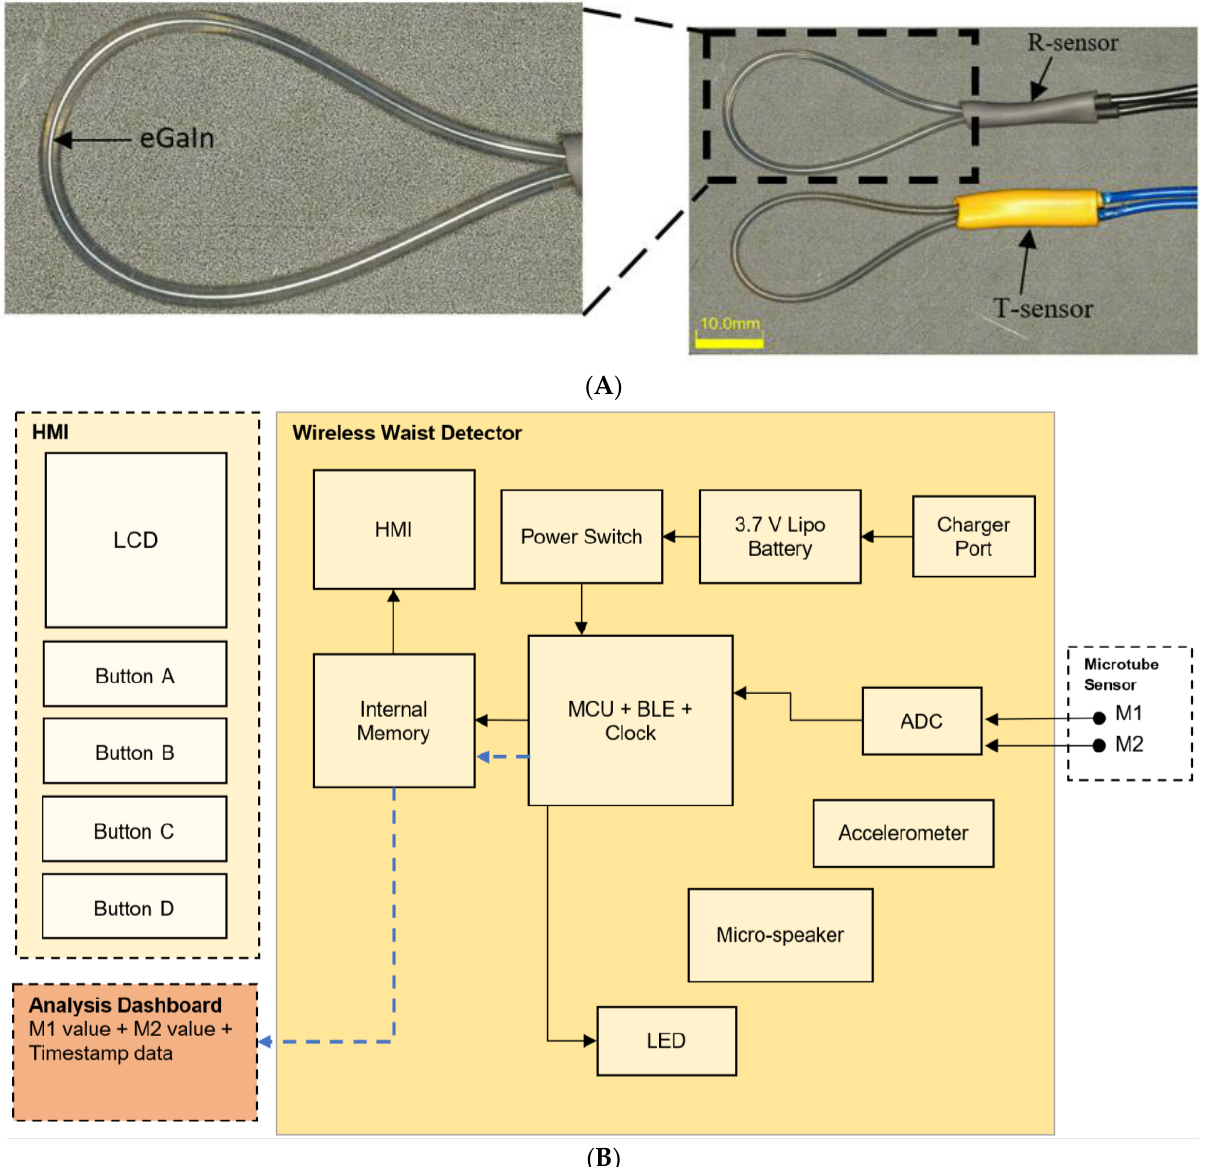
Figure 2. ( A ) Loop-design microtube R-sensor (top) and T-sensor (bottom). ( B ) Electronics system layout and architecture of the waist detector.